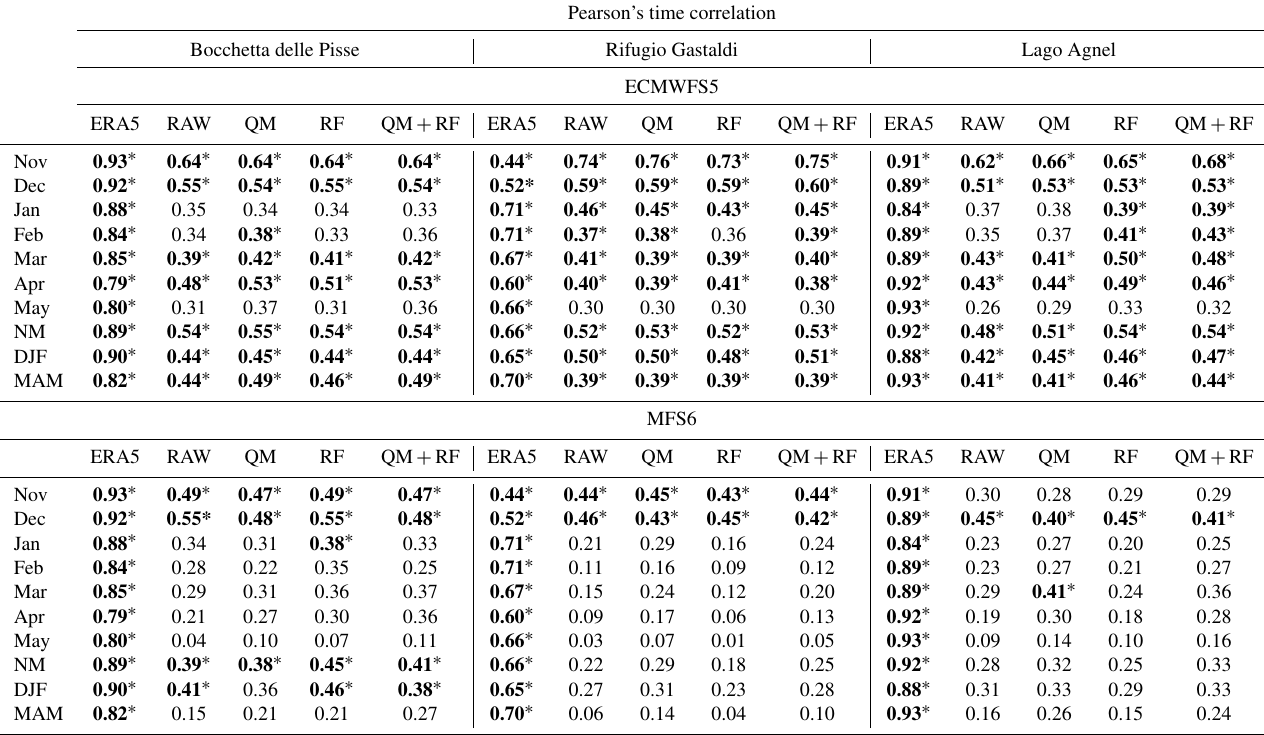
Table 5. Time correlation of the detrended monthly mean snow depth forecasts with respect to observations at the three stations for ECMWFS5 and MFS6 systems. Correlations significant at 95% confidence level are identified in bold and by an asterisk ( ∗ ). Pearson’s time